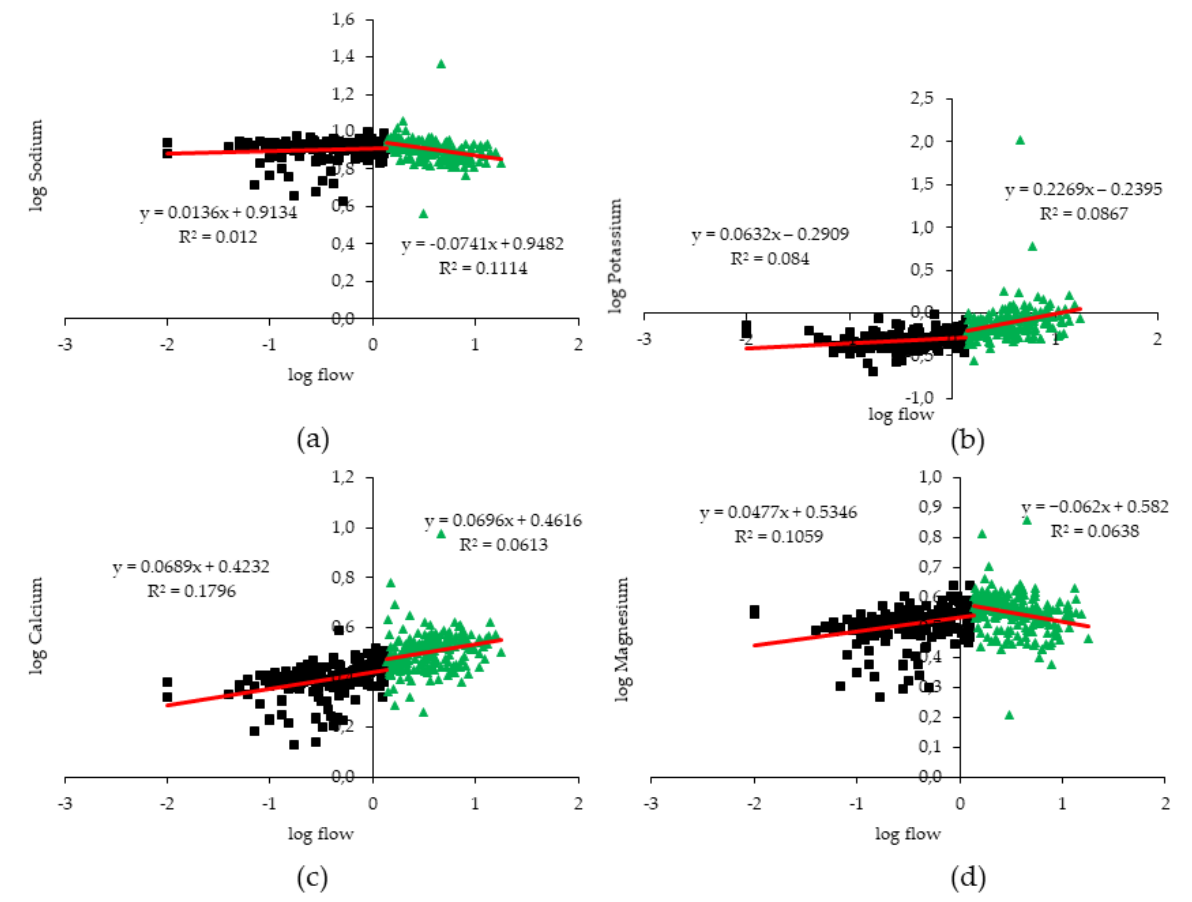
Figure 10. Log [concentration]–Log [discharge] plots for ( a ) sodium, ( b ) potassium, ( c ) calcium and ( d ) magnesium in the Abelar catchment. Regression equations and coefficients are displayed separately for those data below and above the median flow.